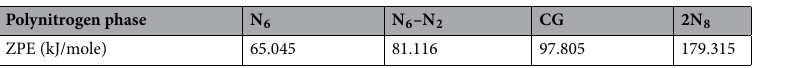
Table 2. The calculated zero-point energies (ZPE) of N 6 , N 6 –N 2 , CG and 2N 8 .